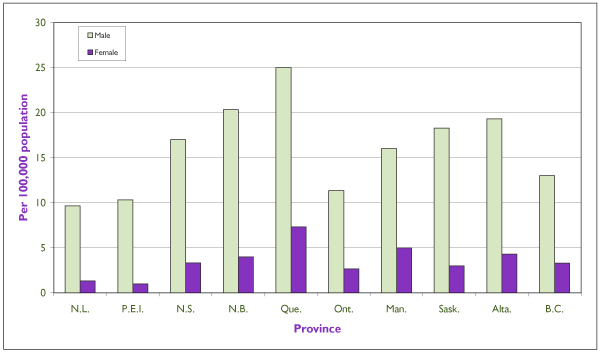
Age-standardized suicide rates,* by sex and province, 1998 Source: Canadian Vital Statistics Database, 1998 (Health Rep 2002;13(2))